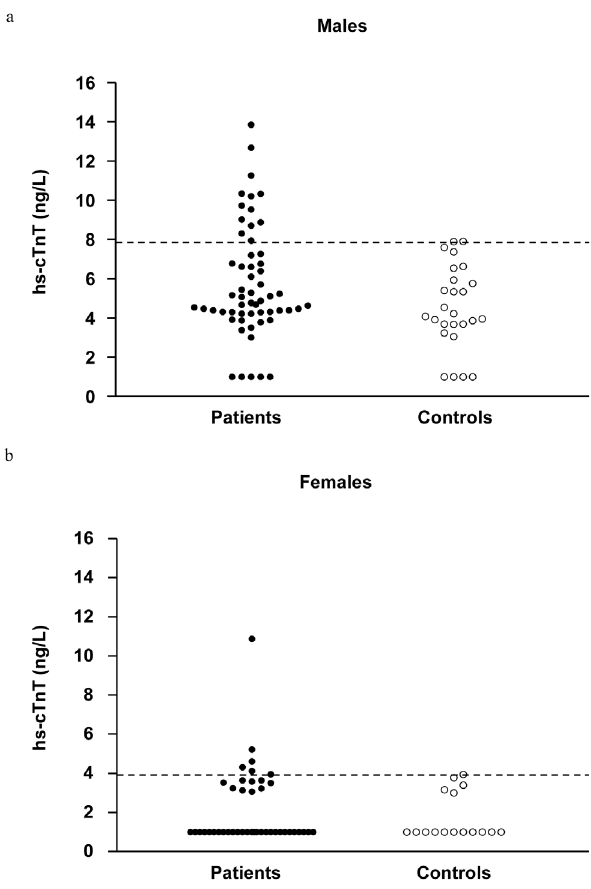
Figure 1. Levels of high sensitivity cardiac troponin T (hs-cTnT) in survivors and controls by genders. Distributions of hs-cTnT in (a) male and (b) female survivors and controls are shown using scatter plots. Dashed lines represent 95 th percentile in controls.